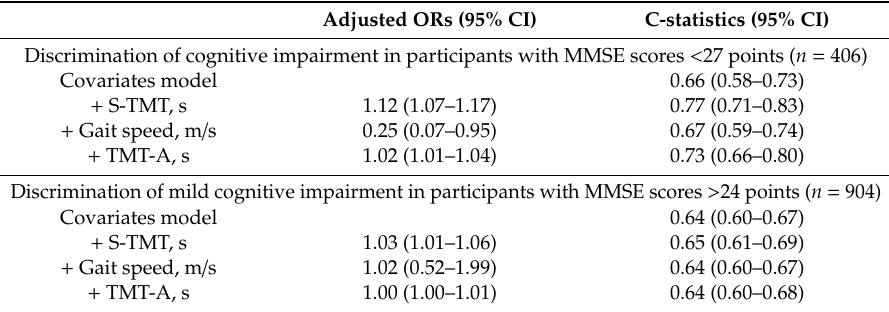
Table 3. Adjusted odd ratios (ORs) and discrimination performance for cognitive impairment and mild cognitive impairment screening between covariates models with the addition of either S-TMT, gait speed, or TMT-A.